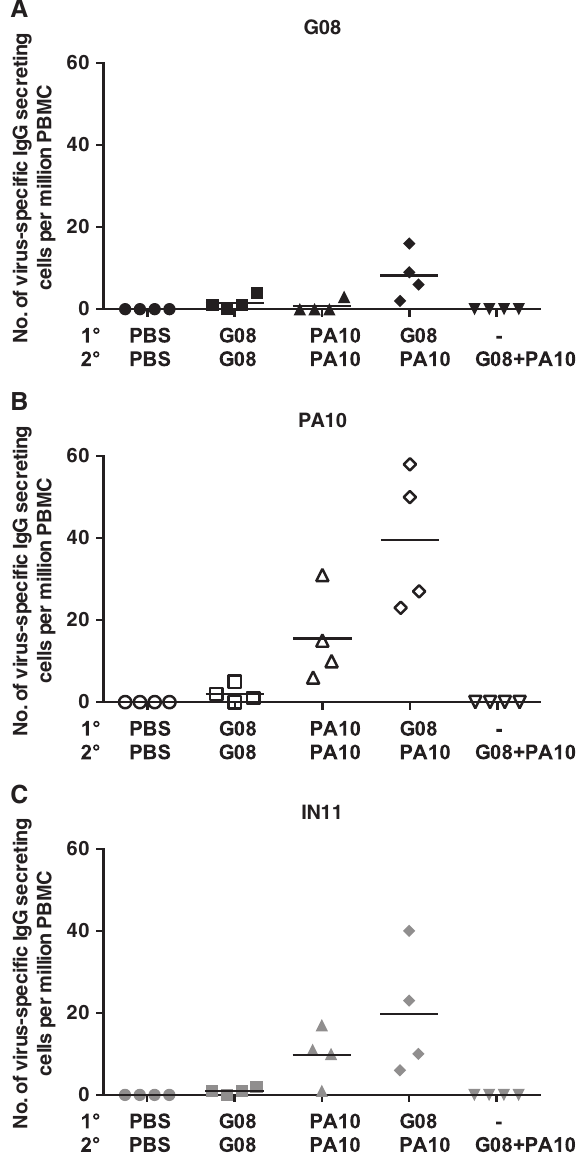
Fig. 2 Higher numbers of vaccine-speci fi c antibody secreting cells (ASC) in pigs of the heterologous prime-boost group as compared to homologous prime-boost and bivalent vaccine (1x) groups. Peripheral blood mononuclear cells of four pigs per group were collected at the time of the booster or single vaccination and 7 days later. Numbers of IgG ASC were determined by direct ELISPOT against three viruses: the vaccine strains G08 ( a ) and PA10 ( b ) and the H3N2v virus A/Indiana/08/2011 (IN11, c ), which is related to PA10. Virus-speci fi c responses were undetectable at the time of vaccination, results 7 days postvaccination are shown. Each data point represents an individual pig, horizontal lines indicate group means. Numbers of virus-speci fi c ASC against all three virus strains were higher in pigs from the heterologous prime-boost group as compared to the mock-vaccinated control and bivalent vaccine (1x) groups ( P < 0.01, Kruskal-Wallis test), and the G08 and PA10 homologous prime-boost groups ( P >